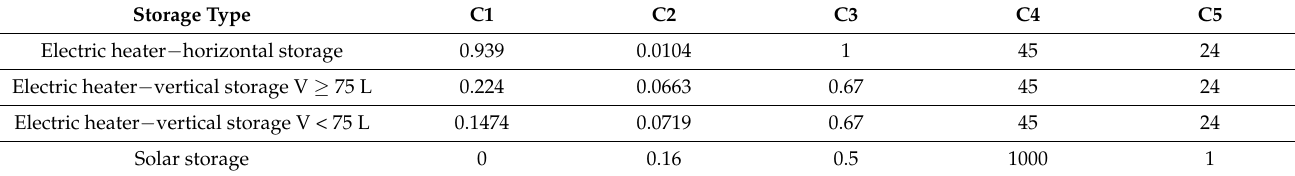
Table A7. Default values for storge heat